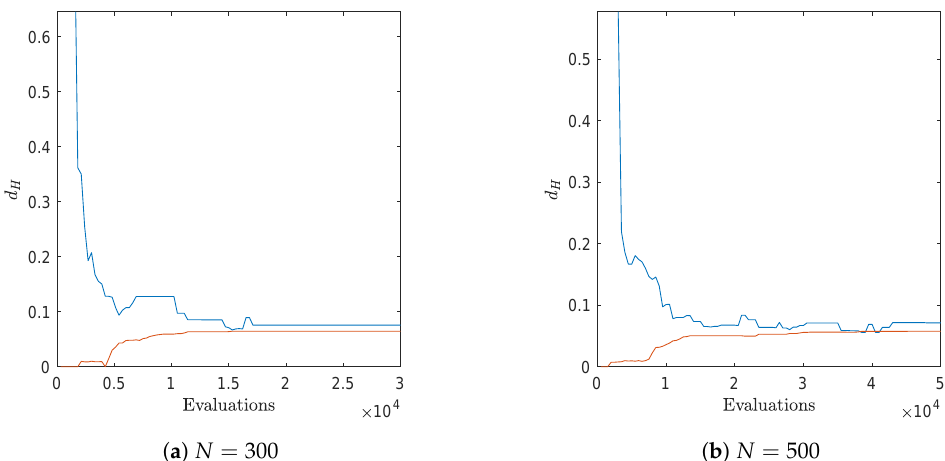
Figure 8. Real (blue) and approximated (red) Hausdorff distances during the run of one algorithm for DTLZ2.